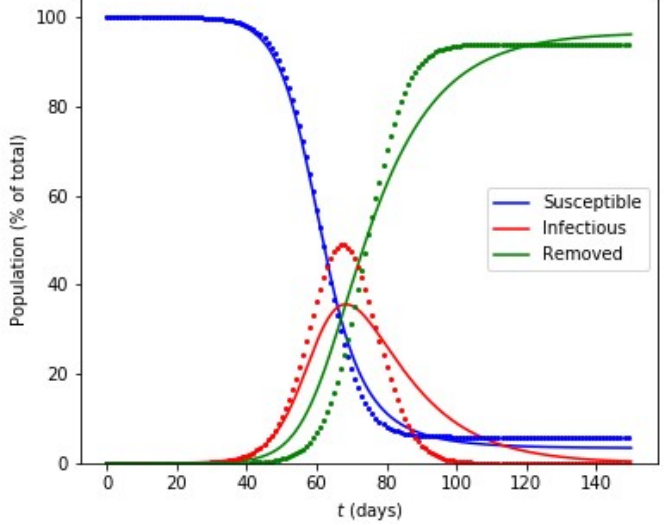
Figure 2. Comparison of the numerical solution to the susceptible-infectious-removed equations (solid lines) and agent-based simulations (points) for a population N. In both cases, we use N=10 6 , β =.25 per day, and 1/ γ = 14 days. For the simulations, the range parameter is D 0 =50 (see text for